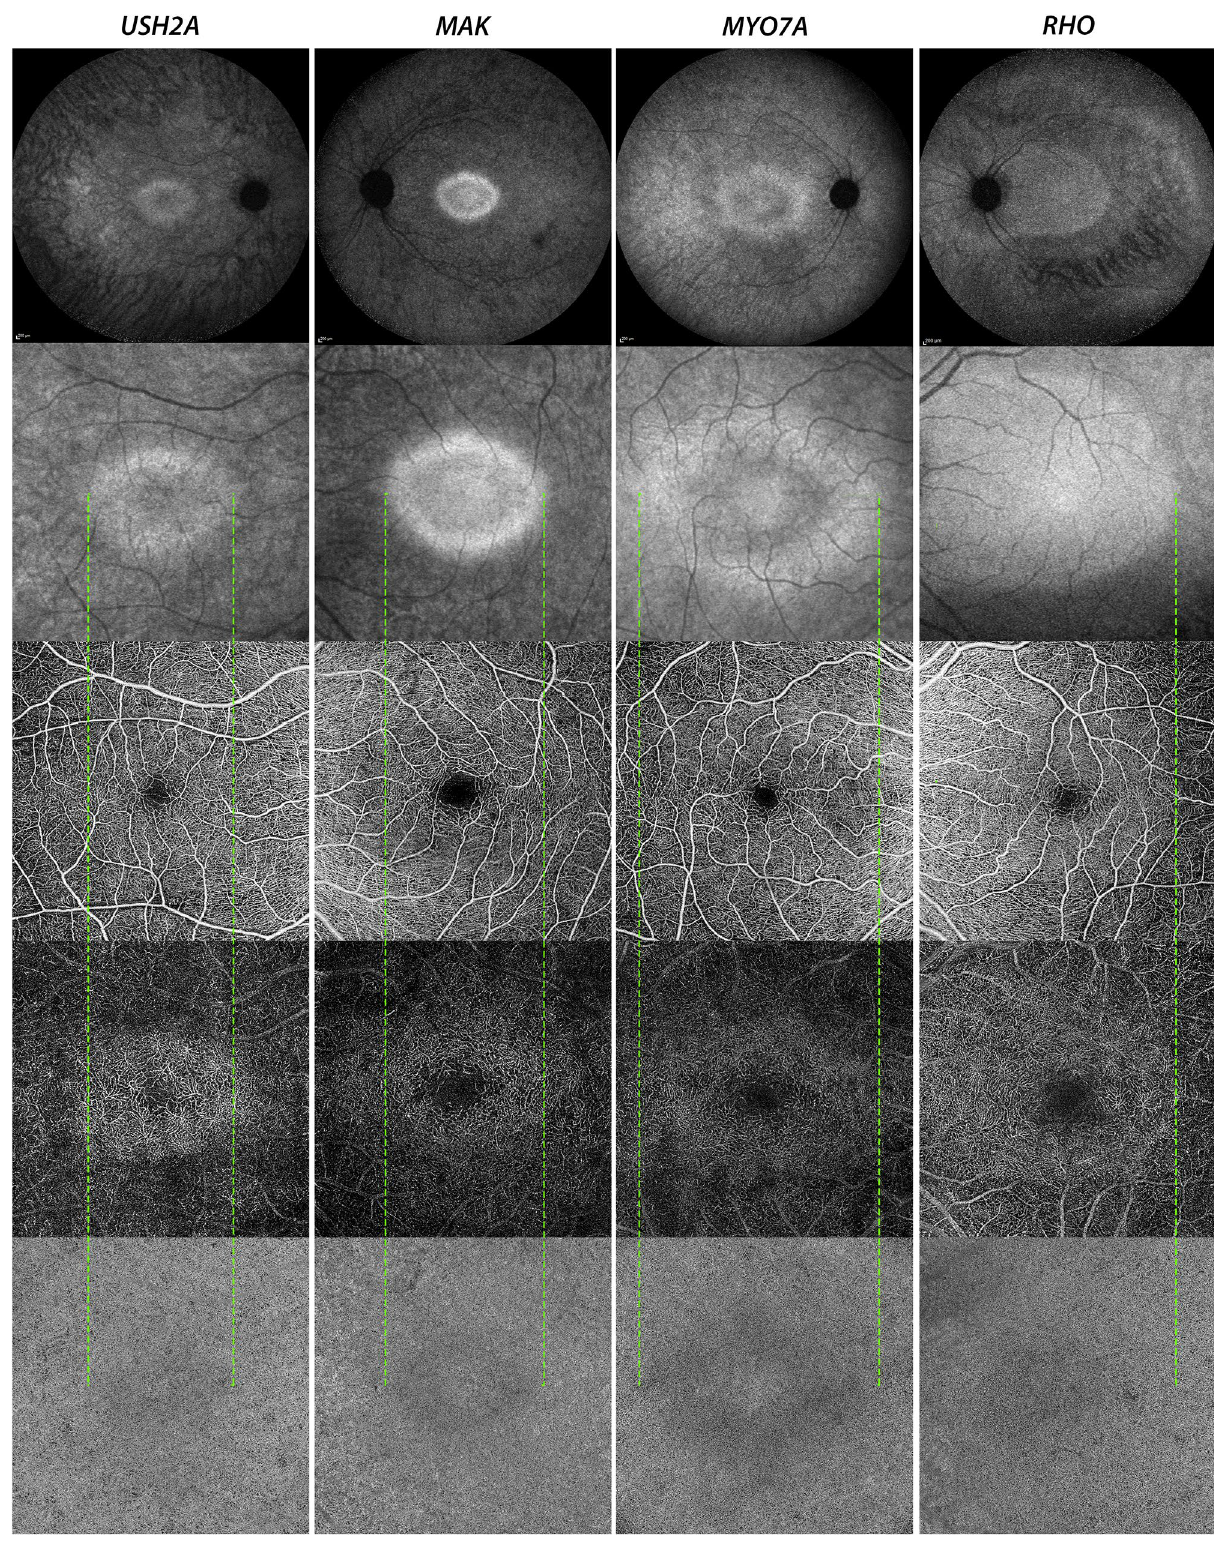
Figure 6. Near-infrared fundus autofluorescence (NIR-FAF, 55° of field top-first image and central 6 × 6 mm top-second image) and optical coherence tomography (OCT) angiograms [superficial and deep capillary plexuses (top-middle and bottom-middle) and choriocapillaris (bottom)] of patients with retinitis pigmentosa from different genetic backgrounds ( USH2A, MAK, MYO7A and RHO ). The vascular alterations outside the NIR-FAF preserved areas, at the level of the DCC and the CC are unrelated to the different genotypes. However, for the CC there was a slightly different degree of involvement. The yellow dotted lines indicate the margins of the area of preserved NIR-FAF. The variable NIR-FAF aspect of the APA with foveal hyperautofluorescence surrounded by hypoautofluorescence in USH2A-, MAK- and MYO7A-related patients or with an isoautofluorescence in the RHO-related patient is physiologic and it is related to the different concentrations of melanosomes in each